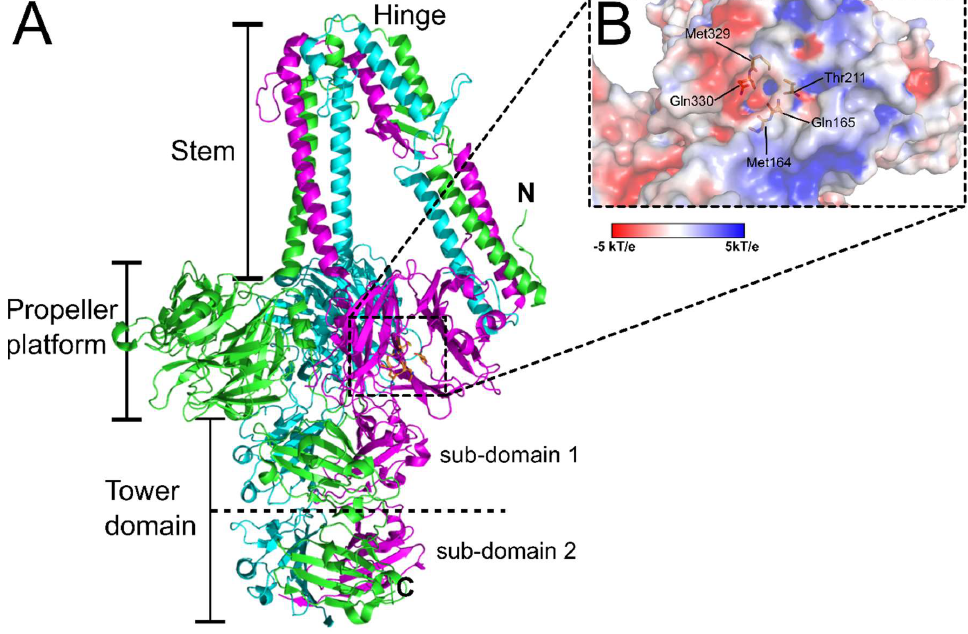
Figure 6. The RBP (gp45) of Staphylococcal phage ϕ11. ( A ) Cartoon representation of the trimeric complex of gp45 (PDB ID: 5EFV) [21] with individual chains colored green, magenta, and cyan, and distinct structural domains indicated. Shown as orange sticks and highlighted by the dashed box are the residues lining a putative GlcNAc binding site cavity featured within each propeller platform domain. ( B ) Zoomed in surface representation of the putative GlcNAc binding cavity colored according to electrostatic surface potential (red = negative charged, white = neutral charged, and blue = positive charged (±5 kT/e)), with all cavity forming residues labeled and represented as orange sticks, as previously described [21].